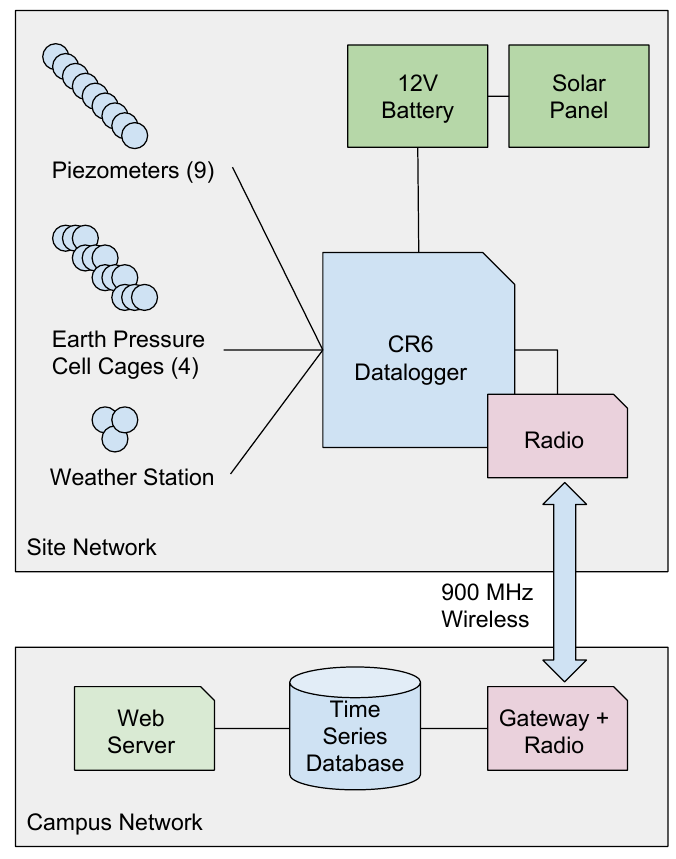
Figure 6. Diagram of the data collection, transport, storage, and visualization plan for the project.